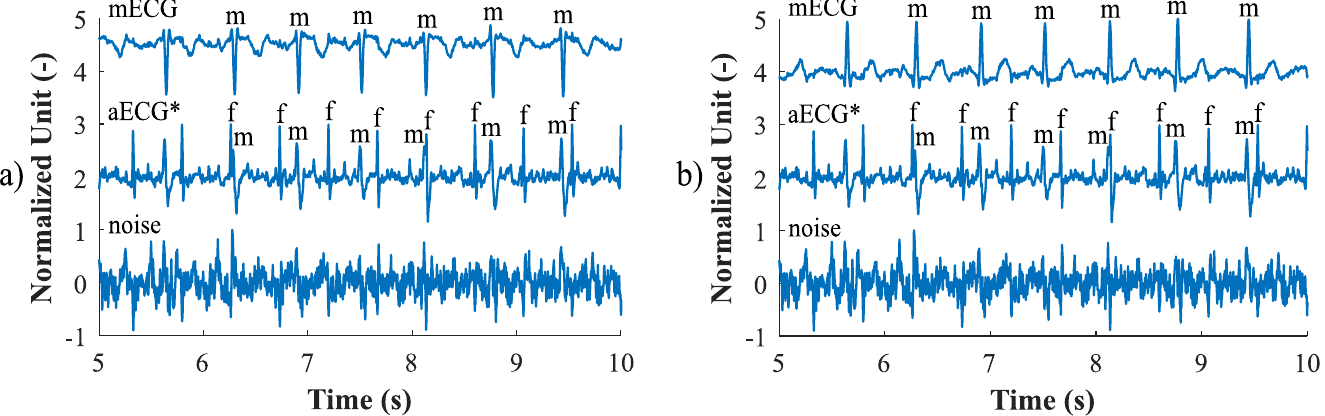
Fig 4. Decomposition of the input aECG signal using the ICA method on three output components (mECG, aECG � and noise): a) inverted polarity of the mECG component; b) mECG polarity correction using the proposed algorithm.